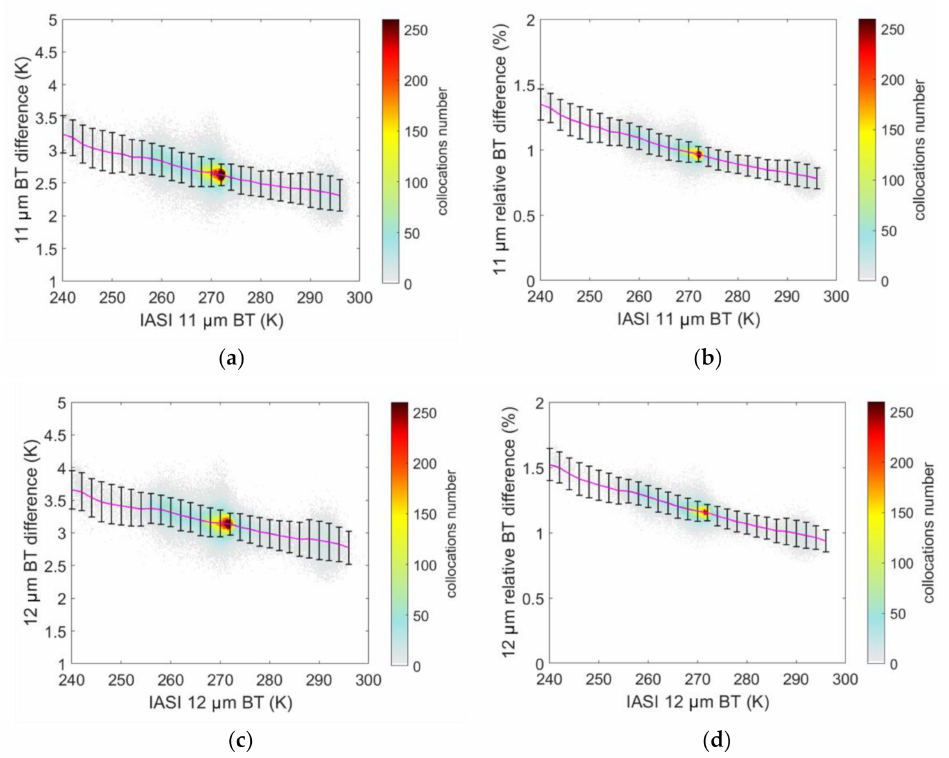
Figure 8. The variations in ( a ) the 11 µ m COCTS minus IASI BT difference, ( b ) the 11 µ m COCTS minus IASI relative BT difference, ( c ) the 12 µ m COCTS minus IASI BT difference, and ( d ) the 12 µ m COCTS minus IASI relative BT difference against the IASI